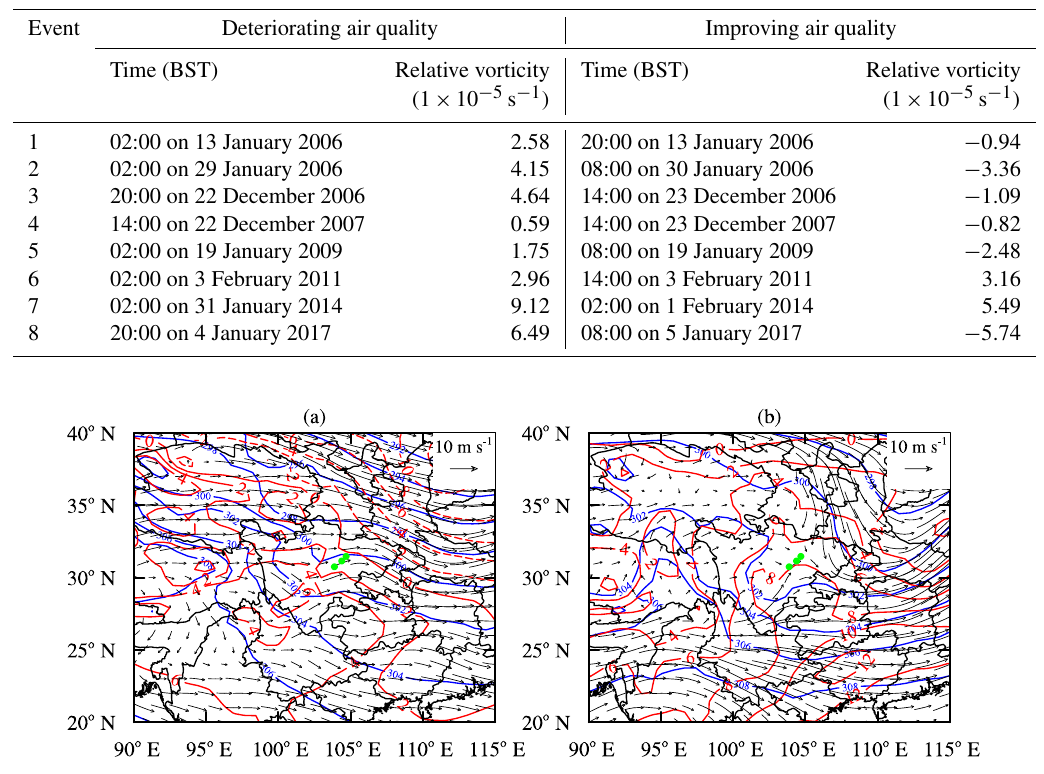
Figure 8. Weather maps at 700hPa during periods of improving air quality (a) for event 6 and (b) for event 7. The blue lines are isopleths of geopotential height, the red lines are isotherms, and the black arrows are wind vectors. The green dots show the location of the urban